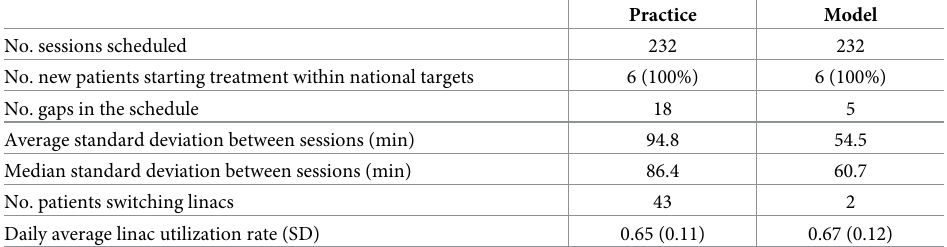
Table 5. Performance comparison between the schedule constructed manually and the MILP model in the